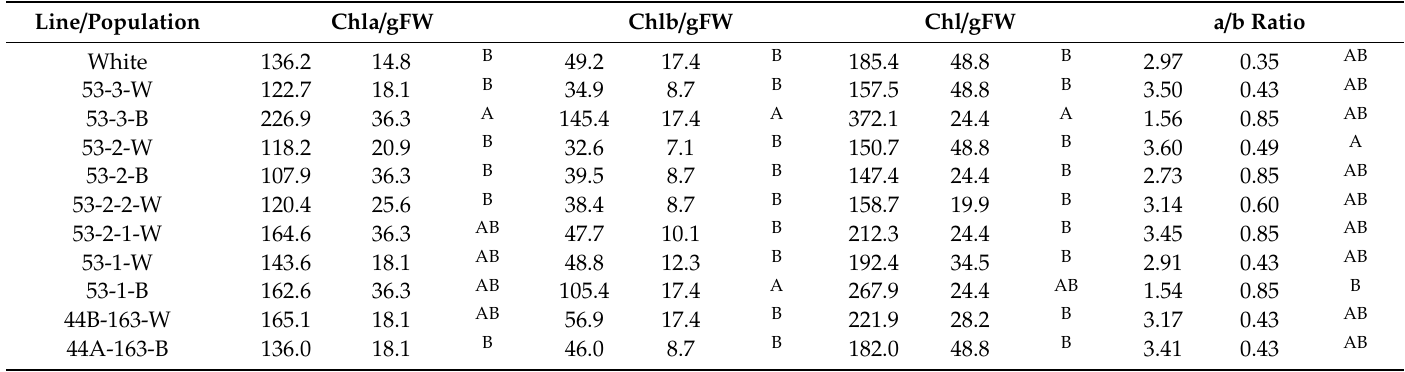
Di ff erent letters indicate significant di ff erences at p <